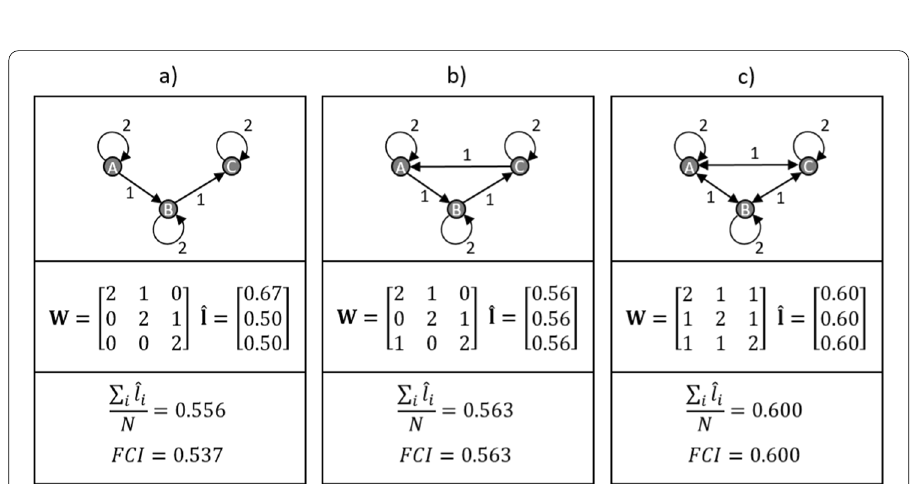
Fig. 2 Three numerical illustrations with three sectors. a represents a no-feedback structure with a single production line. b represents a feedback loop in addition. c represents a completely balanced structure. The calculations assume unit value added or import volumes in all